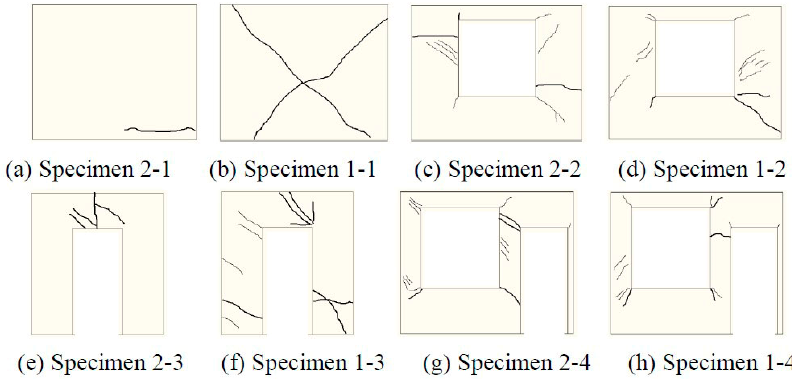
Figure 8. The experimental cracking patterns of the HMES wallboards.